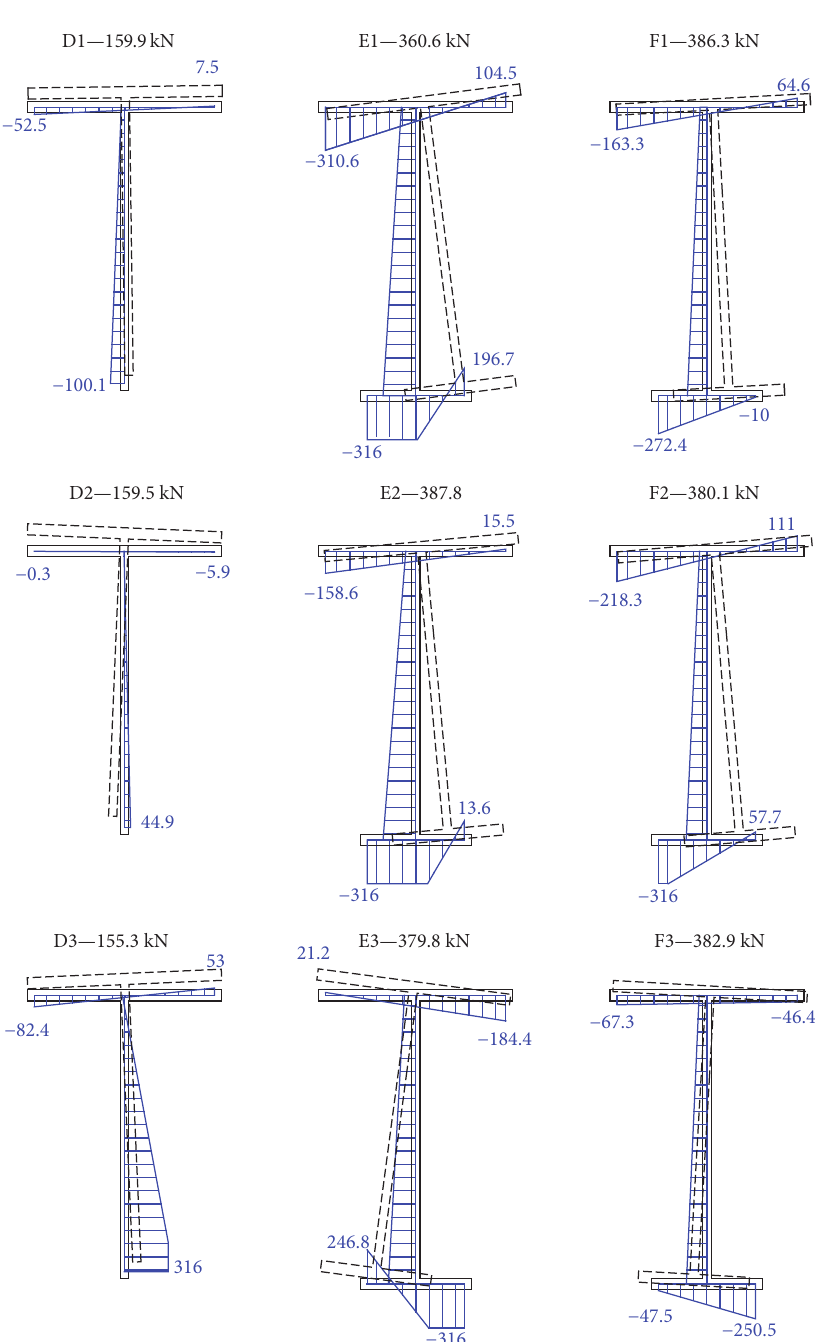
failed via local buckling of the web, as expected (see Figure